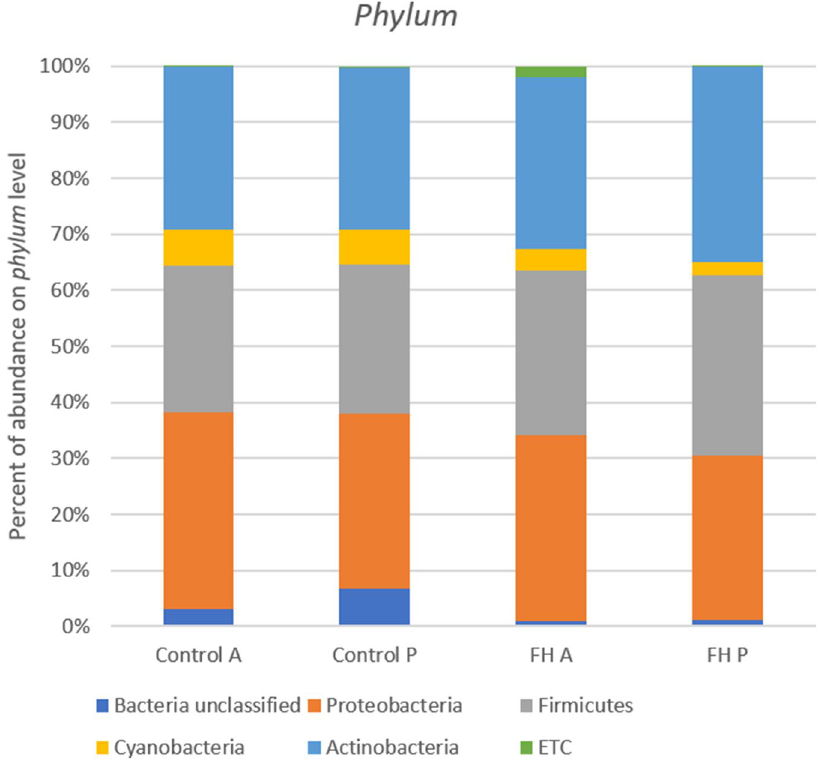
Figure 2. Comparison of microbial communities at phylum level obtained for each diet, Averages were calculated for intragroup. Control A and Control P are referred to the Control diet in the anterior (A) and posterior (P) sections of the intestine. FH (number)-A and FH(number)-P are referred to the supplemented diet with N. gaditana in the anterior and posterior sections of the intestine. ETC: phylum represented <